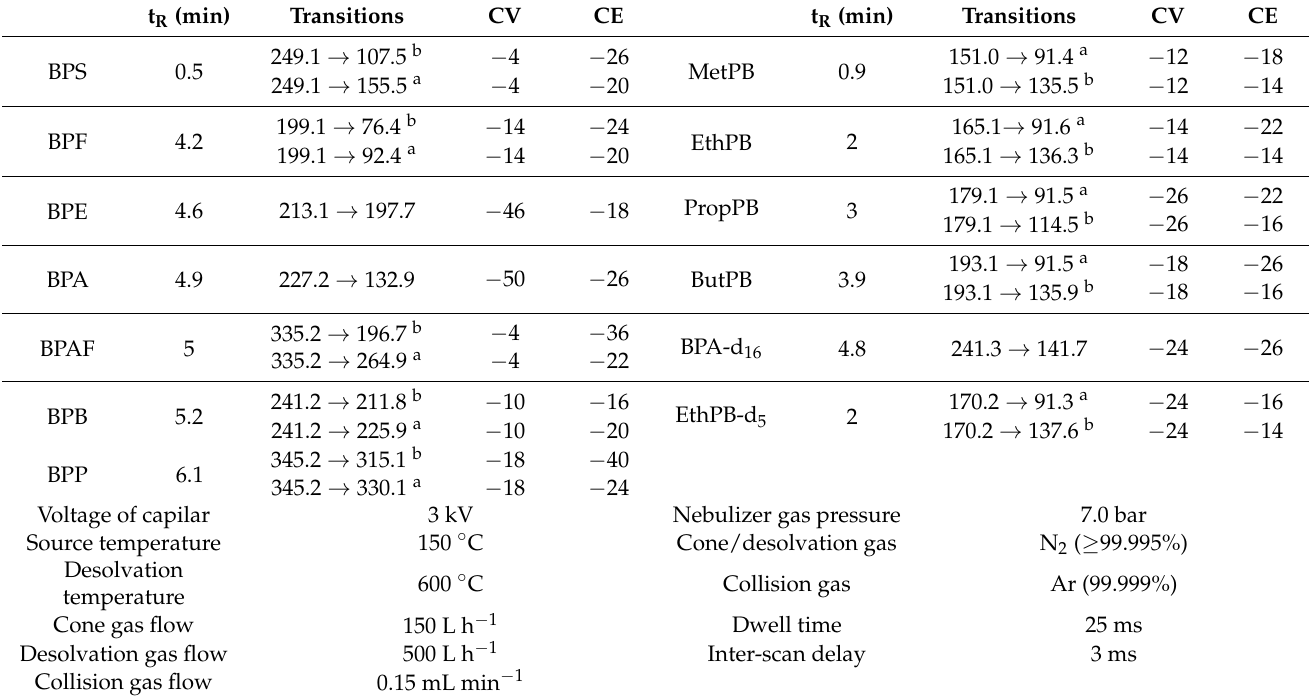
Table 1. Optimized parameters for the Ultra-high performance liquid chromatography-tandem mass spectrometry (UHPLC- MS/MS) analysis of